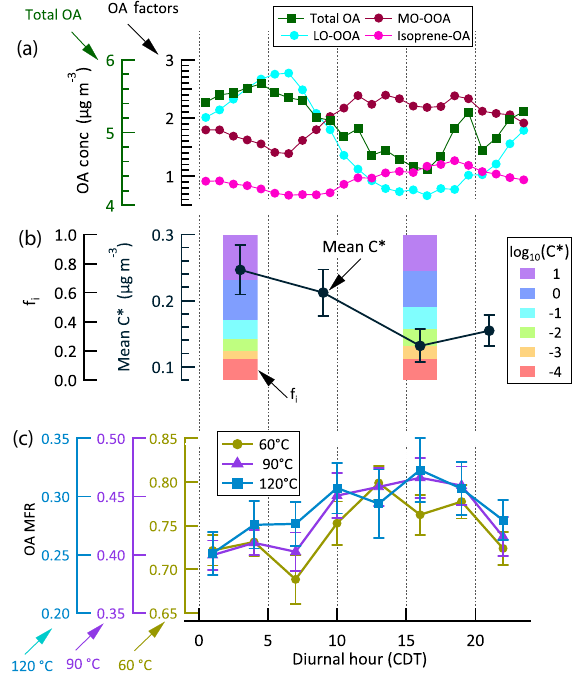
Figure 7. Campaign-average diurnal trends for the Centreville mea- surements of (a) concentrations of total OA and OA factors, (b) OA volatility ( f i and mean C ∗ ), and (c) OA MFR after heating at 60, 90, and 120 ◦ C with a TD residence time of 50s. Figure S11 shows similar analysis results for the Raleigh dataset. PMF factors in panel (a) are LO-OOA: less-oxidized oxygenated OA; MO-OOA: more-oxidized oxygenated OA; and isoprene-OA: isoprene-derived OA (for details on OA factors analysis see Xu et al., 2015a,